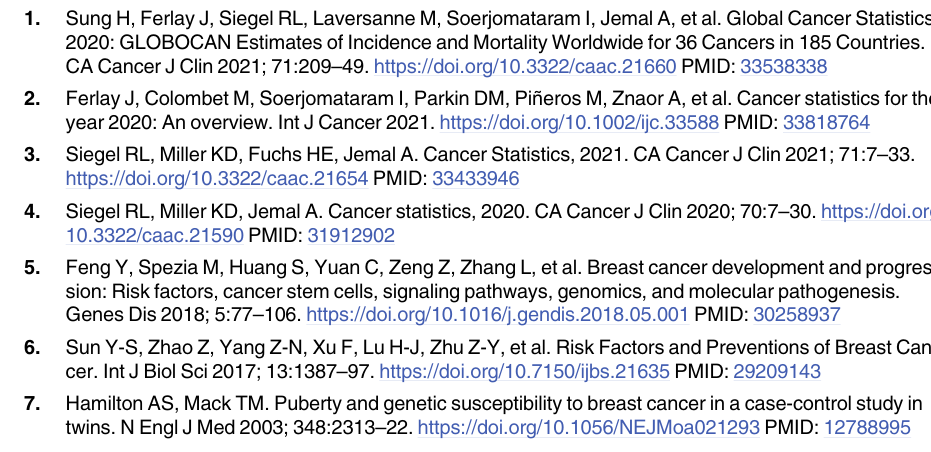
S3 Table. Comparison of various combinations (3 × 5 × 9 = 135) of imputation methods, feature selection methods, and ISD